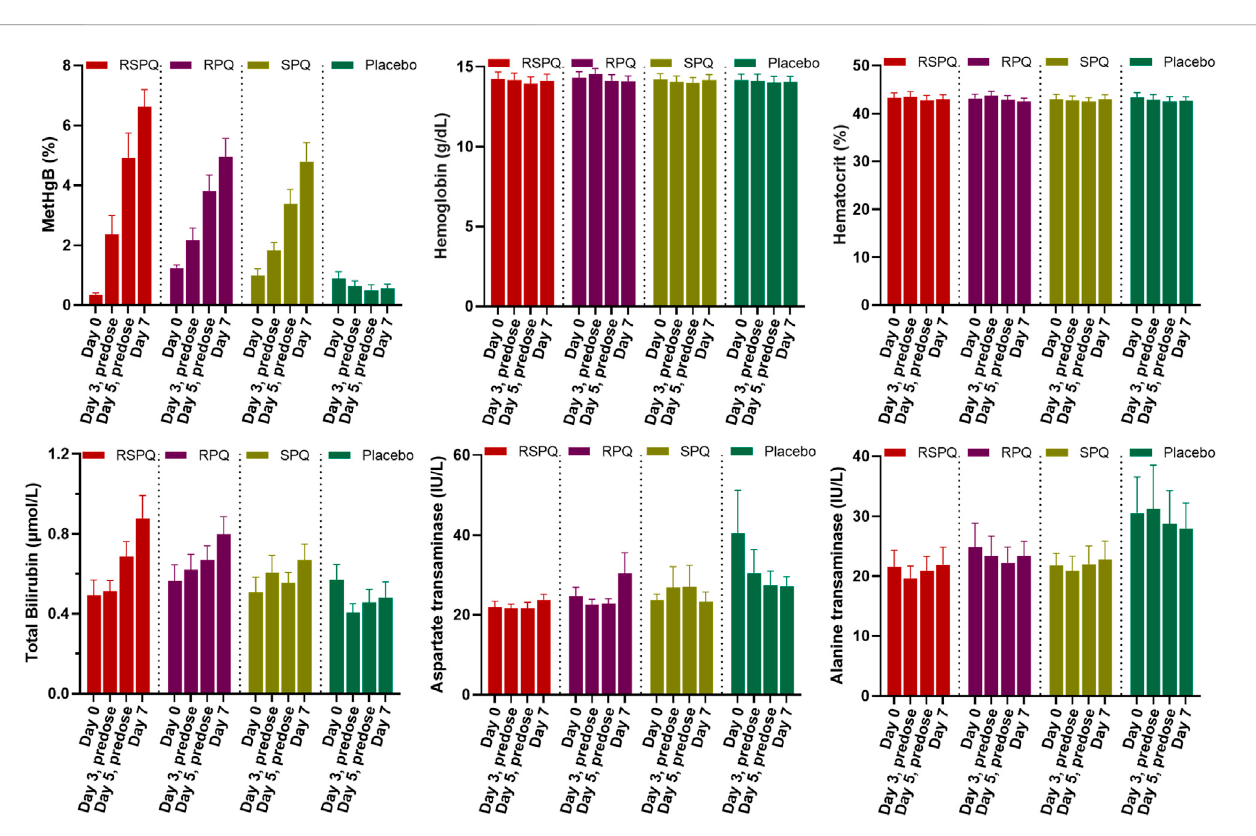
BiochemicalandhematologicalparametersinG6PDnsubjectsduring7 daysdailyoraladministrationofPQanditsindividualenantiomers.Bargraphsare presented as mean with SEM ( N =